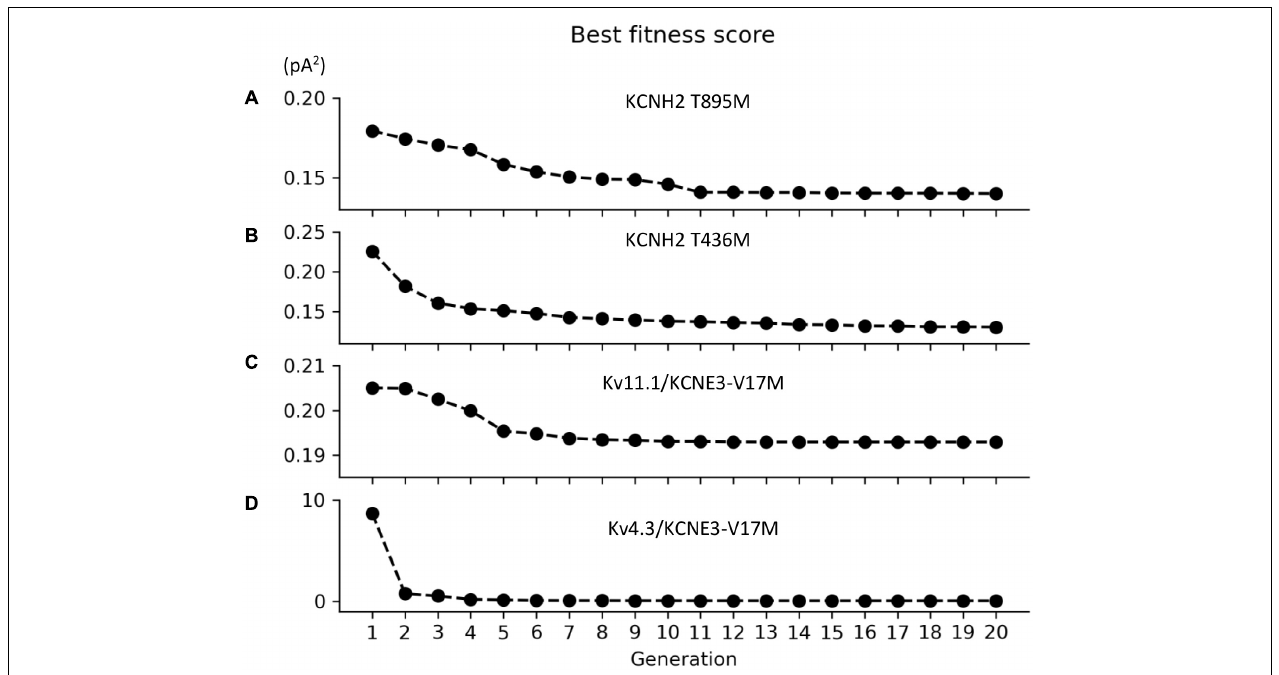
FIGURE 1 | Convergence of the root-mean square value (pA 2 ) of the best individuals as function of the generation for the (A) KCNH2 T895M, (B) KCNH2 T436M, (C) Kv11.1/KCNE3-V17M, and (D) Kv4.3/KCNE3-V17M mutations.